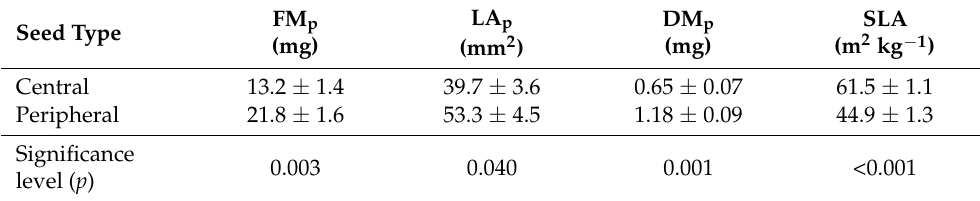
Table 9. Mean values ( ± SE) and significance level ( p ) of the morphological properties of 8-day-old